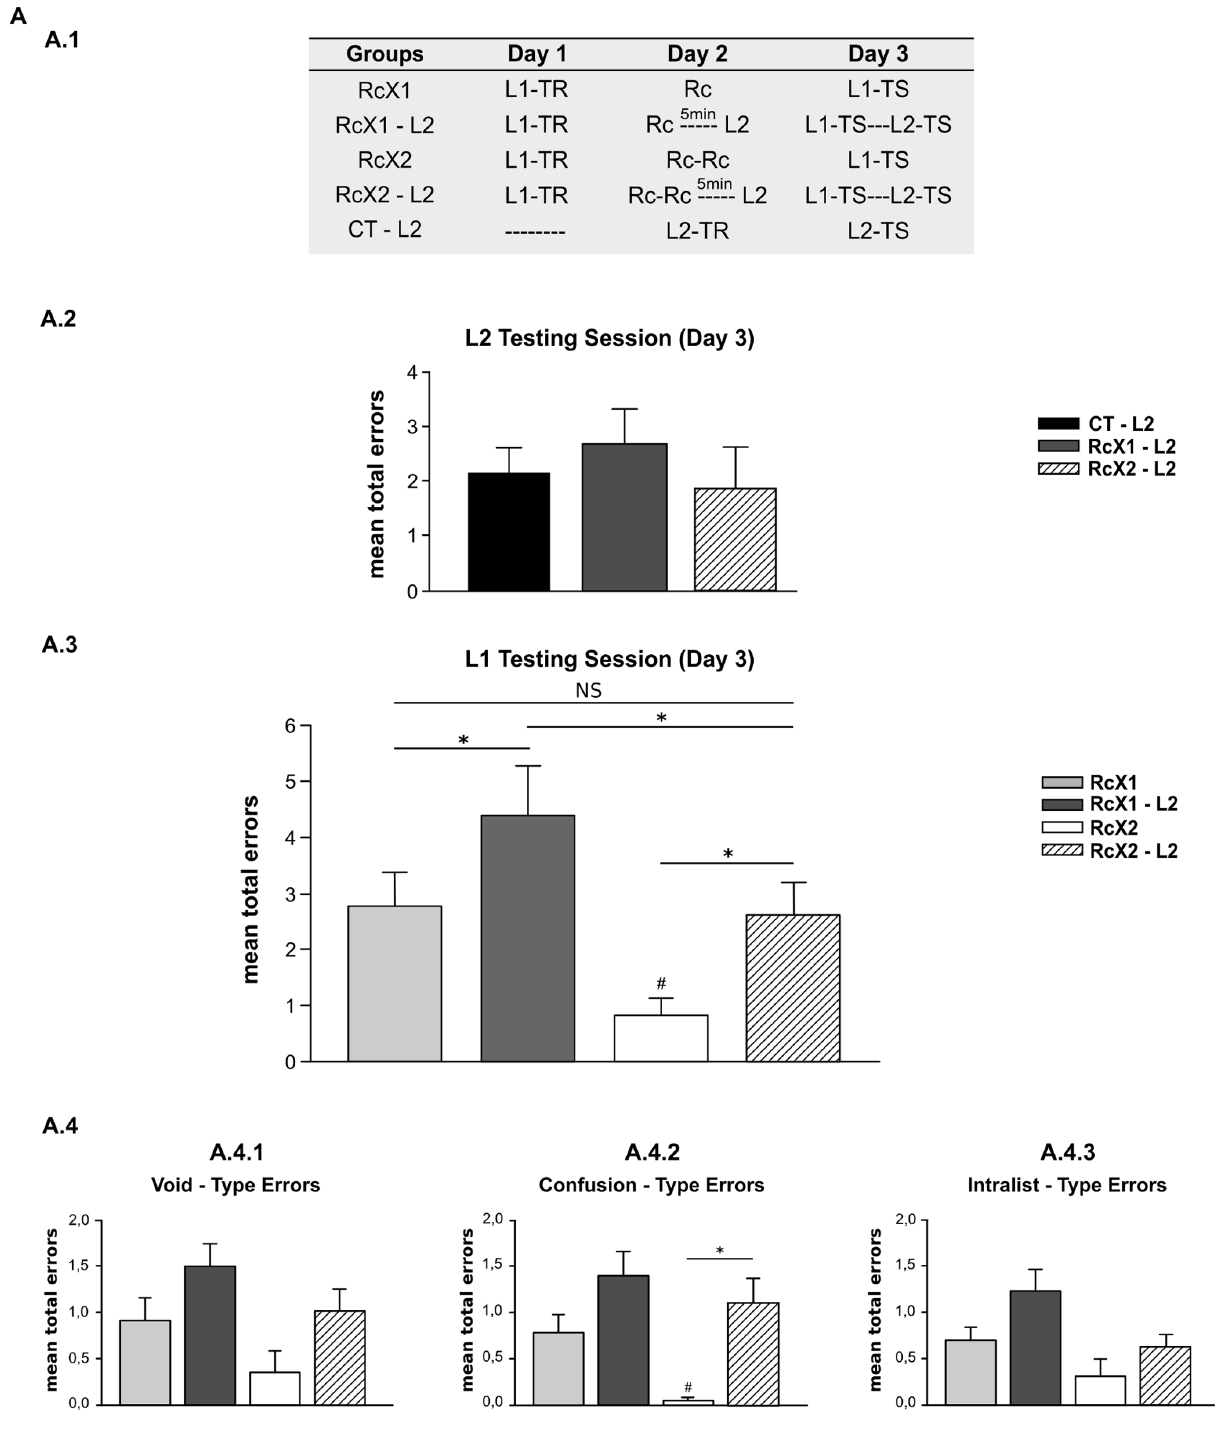
Figure 2. Strengthened memories by repeated labilization-reconsolidations are more resistant to be interfered with a second task. A) Experiment 2.A (n=13). A.1) Experimental protocol. A three-day experiment . Rc–L2, stands for the presentation of the cue reminder and five minutes later the acquisition of the Interference task List-2 ( L2 ), L2-TR for the training in L2, L2-TS for the testing of that list and the remaining symbols as in Experiment 1. Groups differ in the number of reminders received and the presence or absence of the L2 list. Groups RcX1 and RcX2 as in Experiment 1. Group RcX1– L2 received a cue reminder and five minutes later learned L2 list, Group RcX2– L2 received two cue reminder and five minutes later learned L2 list, Group CT-L2 only learned L2 list on Day 2. A.2) L2 Testing Session. Mean number of total errors + / 2 SEM on Day 3. Black bar stands for Group CT-L2, Dark Gray bar for Group RcX1-L2 and Stripe bar for Group RcX2-L2. A.3) L1 Testing Session. Mean number of total errors + / 2 SEM on Day 3. *, p , 0,05. Symbols as in Experiment A.2 and Experiment 2 A.2. A.4) Error Type. A.4.1) Mean number of Void-Type error errors + / 2 SEM on Day 7. A.4.2) Confusion-type errors. A.4.3) Intralist-type errors. Symbols as above.